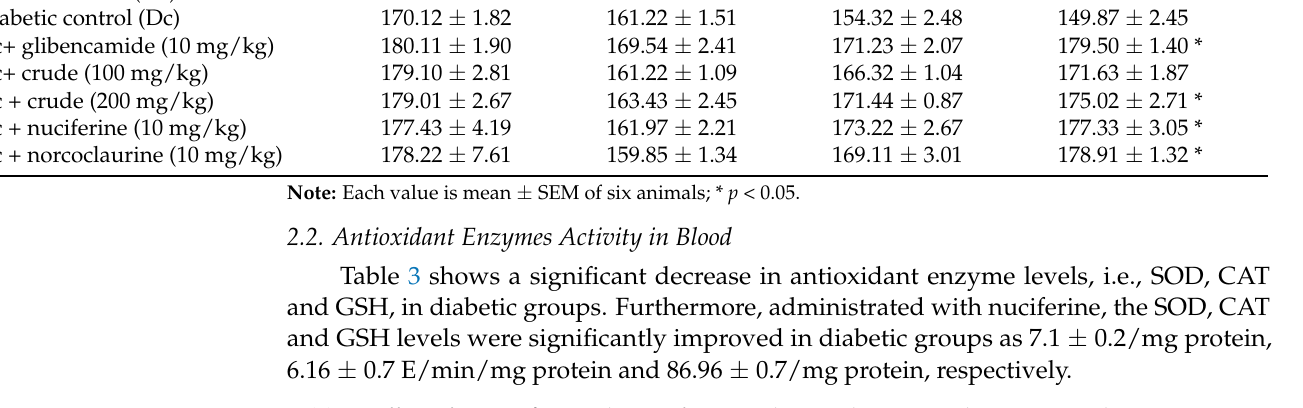
Table 3. Effect of N. nucifera crude, nuciferine and norcoclaurine on the TBARS and SOD, CAT, GPx and GSH enzymes activities in diabetic